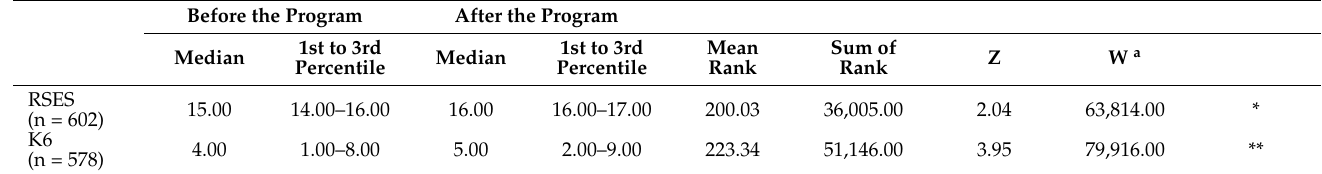
Table 3. Comparison of the K6 and Rosenberg Self-Esteem Scale before and after the program.